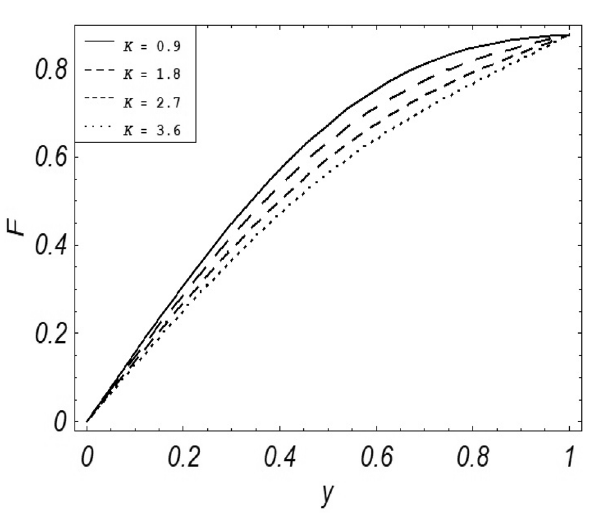
Figure 4. Evolution of F with various values of K if t = 1 ; Gr = 2.5 ; N = 0.7 ; η = 2 ; Gr = 2.5 � = 0.5 ; Re = 1 ; α = 0.1 ; ω = 0.5 ; ε = 0.001